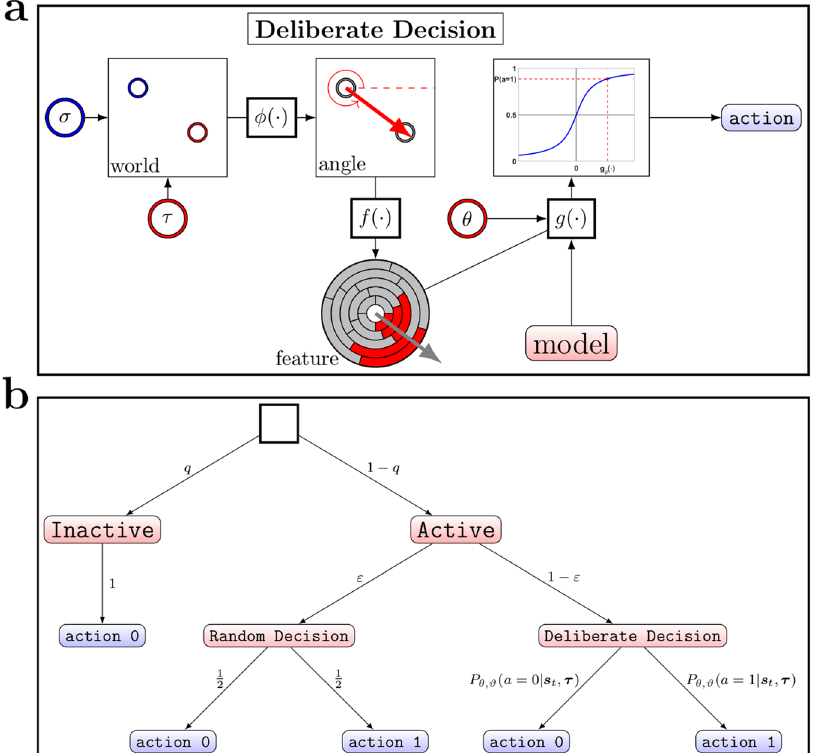
Figure 10. Decision-maker. Detailed sketch of the decision making process for the simulated units. ( a ) Overview of the deliberate decision, following a sigmoid decision function strategy. In a first step the world- state is determined. The function φ maps this state, i.e. the position of the cursor and the position of the target, onto the target difference vector angle. This angle is then transformed into a binary feature vector. ( f) The activation level ⋅ g ( ) then determines a scalar value, i.e. a reaction to f , according to his type and his existing knowledge θ . This value is then used in a sigmoidal decision function that determines the decision-maker’s action. ( b ) Schematic of the binary decision-maker’s structure. In a first step the decision-maker is either with probability q forced to staying idle (action 0) or he is allowed to follow an ε -greedy strategy with probability − q 1 . Following the ε -greedy strategy, the decision-maker chooses his action at random with a probability of ε or sticks to an atan decision function with probability ε − 1 . The activation level g f ( ) to the feature f used to θ evaluate the sigmoid decision-function is a scalar that is large for features similar to the best guess of the decision-maker’s movement direction and negative for features representing antagonistic movement